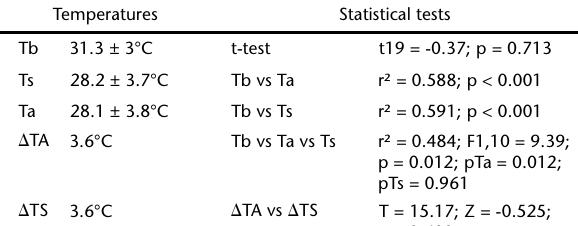
With respect to the degree of behavioral thermoregula- tion (Fig. 8), median (cid:2) TA (M = 3.6°C, n = 20, Tab. I) and (cid:2) TS (3.6°C, n = 20, Tab. I) values were equal, with no significant dif- ference among the remaining values (paired Wilcoxon, T = 15.17,